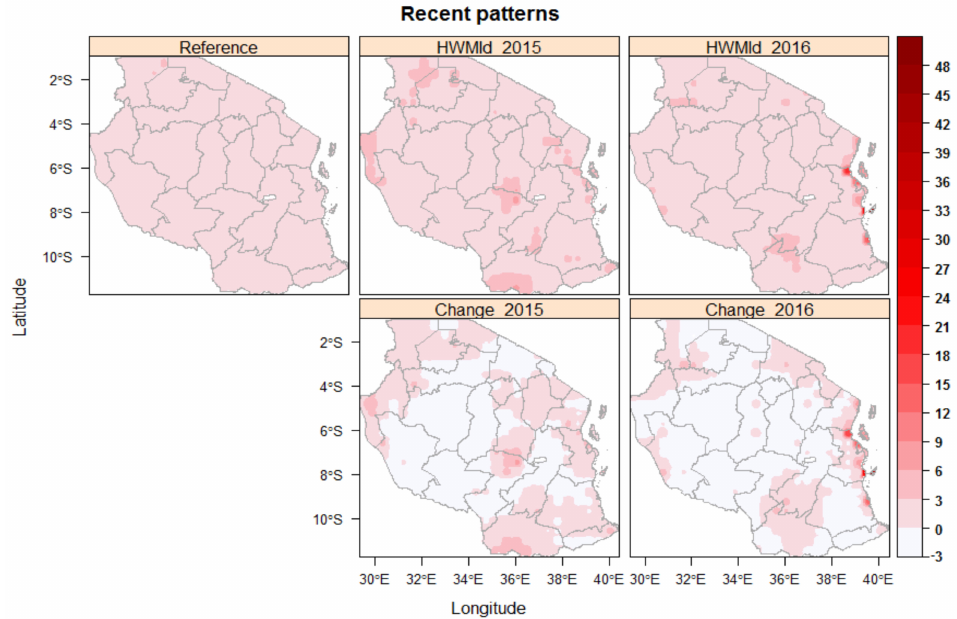
Figure 2. Recent patterns of heatwave events: spatial distribution of absolute values for 2015 and 2016 (top layer) and their changes (bottom layer) relative to the reference period (upper